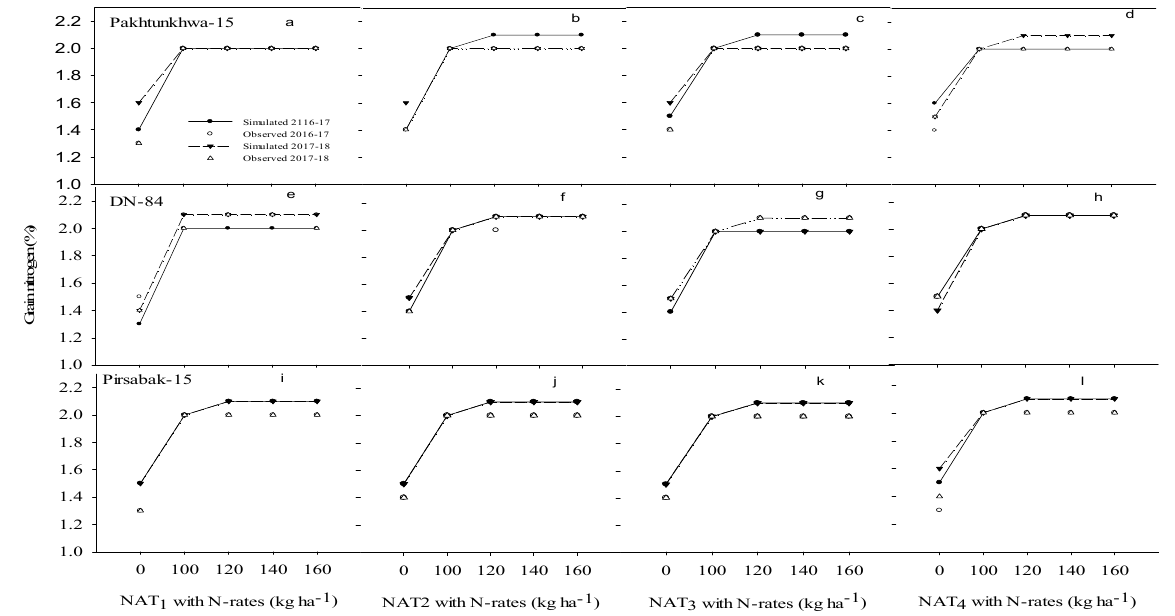
Figure 7. Using CSM-CERES-Wheat to predict grain nitrogen (%) as a function of N application at different stages: full N application (N 100% ) at sowing ( a , e , i graphs), half of recommended N applica- tion (N 50% ) at sowing + N 50% at tillering ( b , f , j graphs), quarter of recommended N application (N 25% ) at sowing + N 50% at tillering + N 25% at booting ( c , g , k graphs), and N 25% at sowing + N 25% at tillering + N 50% at booting stage ( d , h , l graphs) for different cultivars.